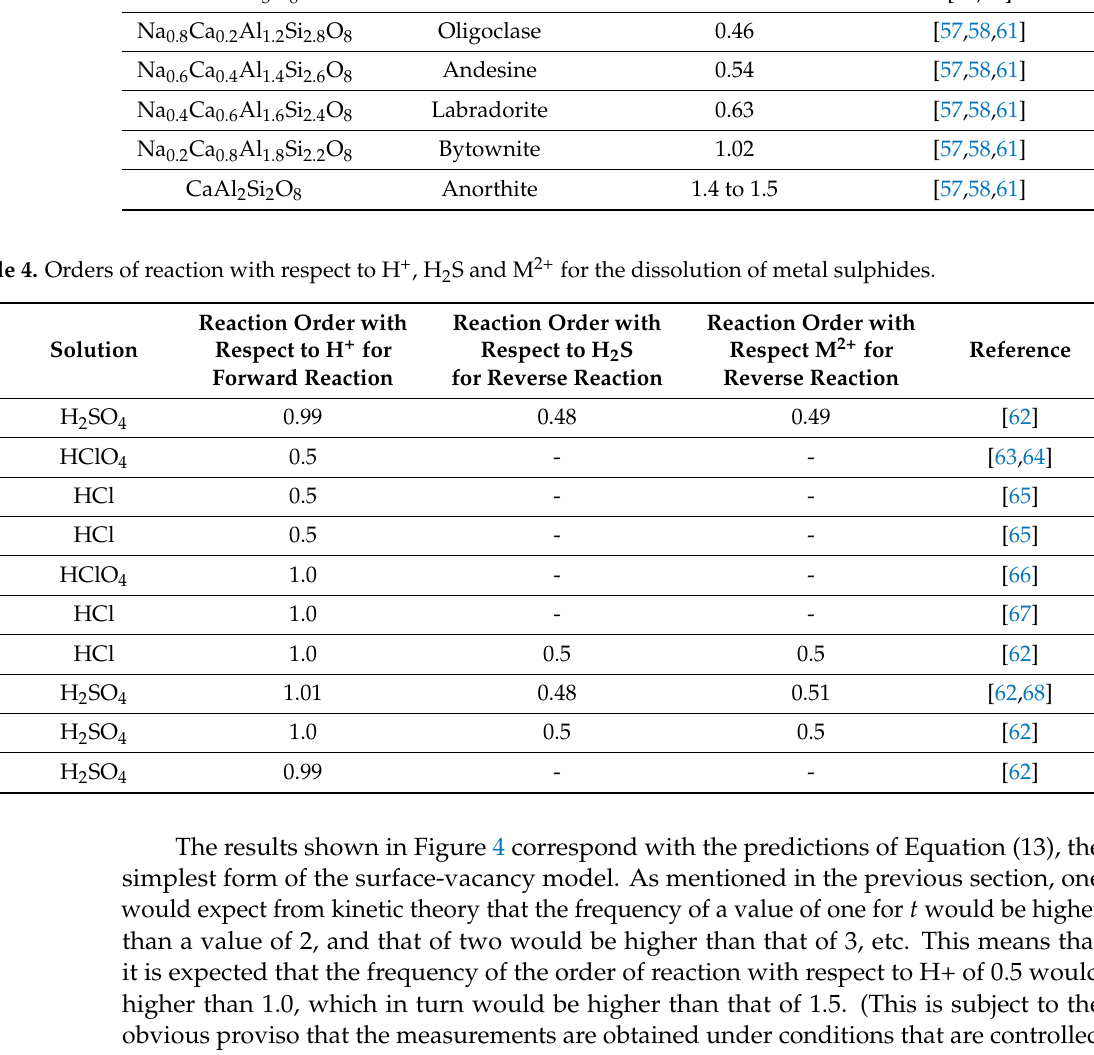
Table 3. Orders of reaction for the dissolution of the feldspars at 25 ◦ C.